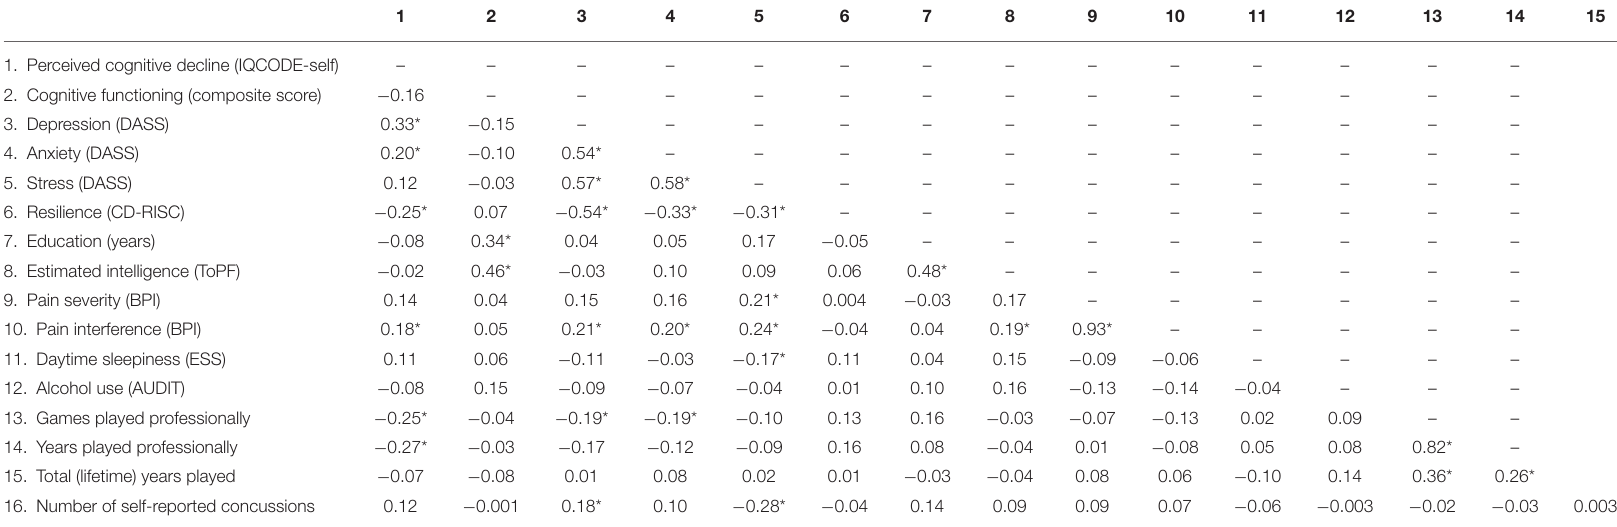
TABLE 4 | Bivariate correlation